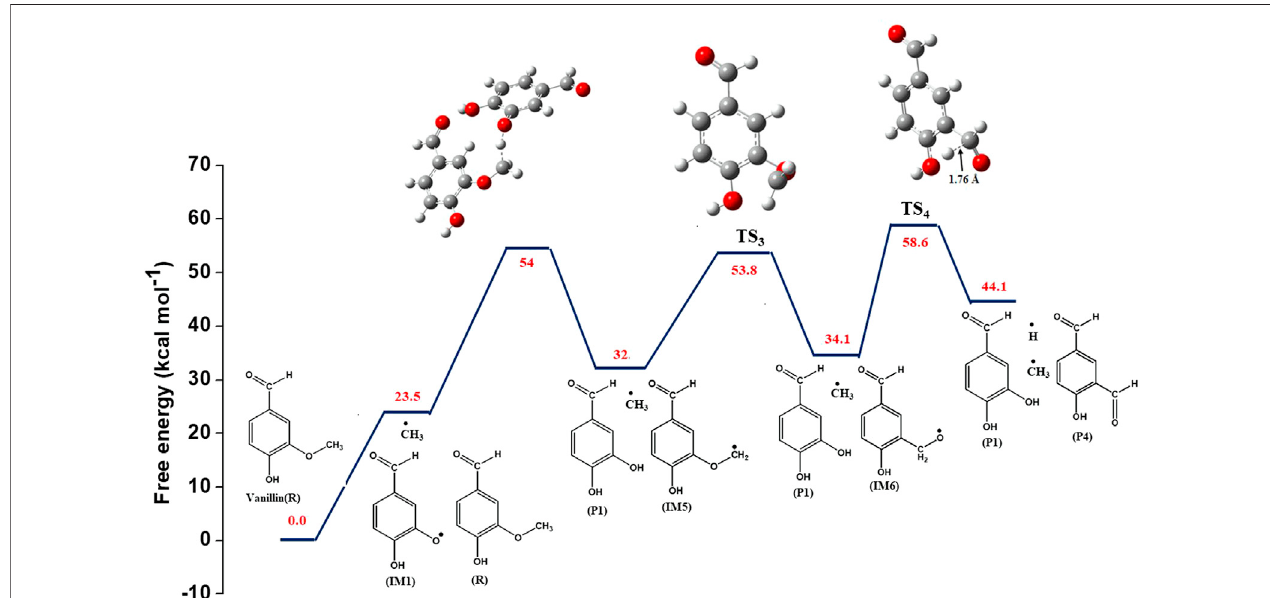
FIGURE 3 | Potential energy pro fi le for the transformation of vanillin to 5-formylsalicyaldehyde.